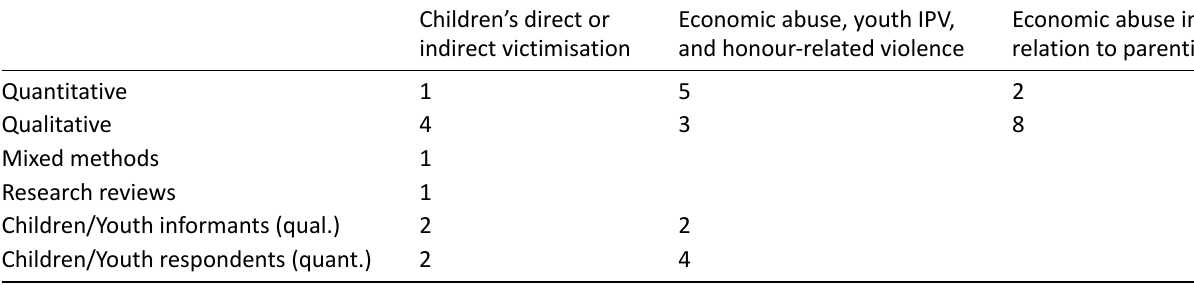
Table 1. The empirical base of studies reviewed.